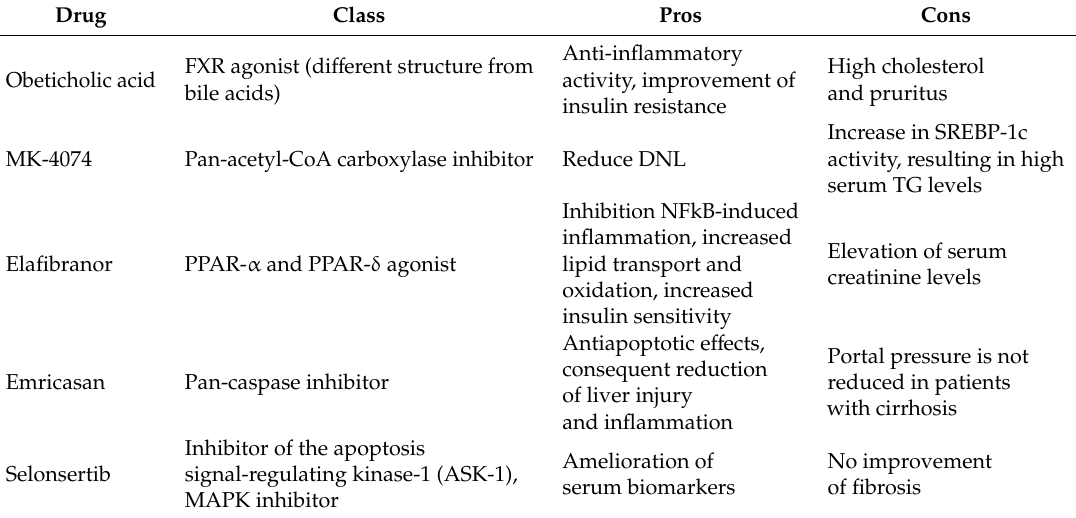
Table 2. Drugs currently at various stages of development for the therapy of